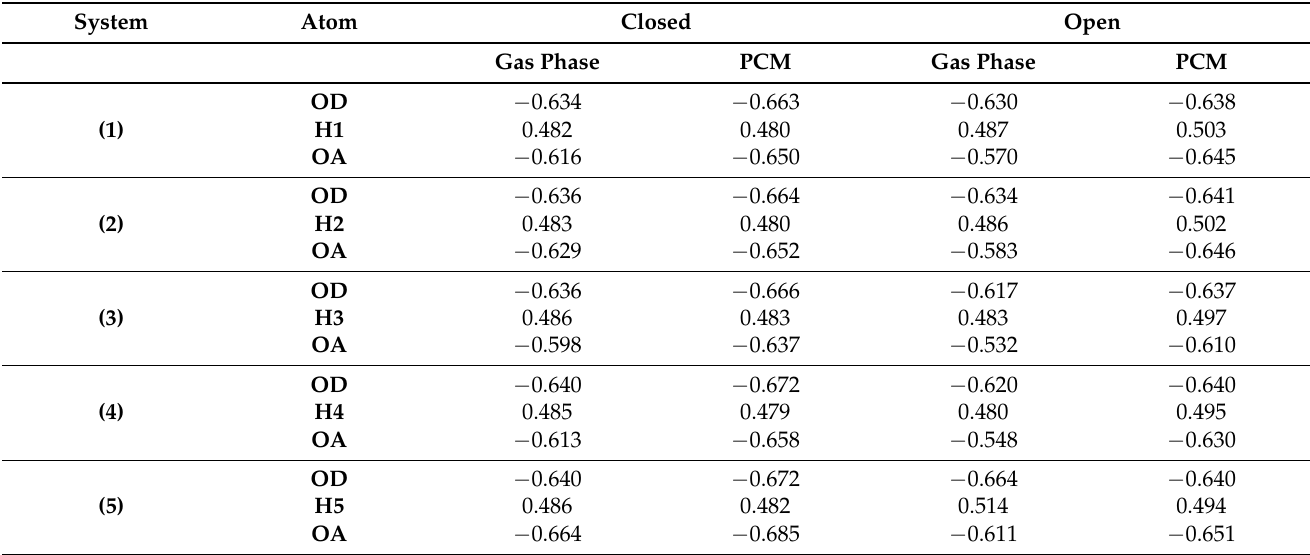
Table 3. NPA atomic charges for the atoms involved in the intramolecular hydrogen bond formation computed at the PBE-D3/aug-cc-pVTZ level of